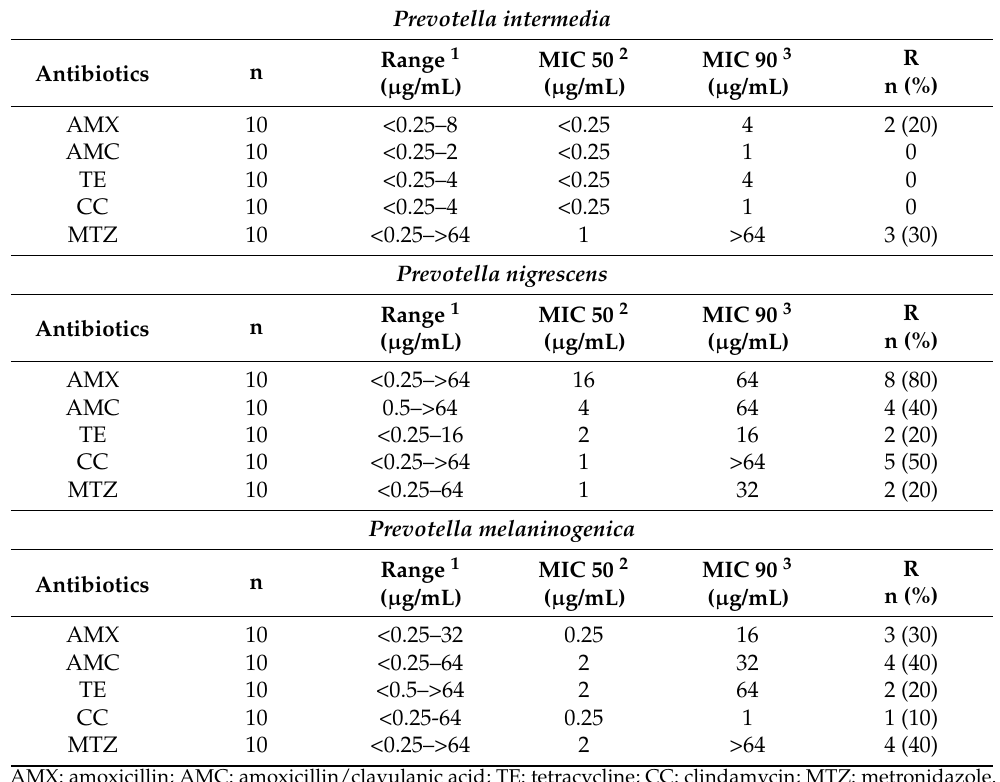
Table 3. Minimum inhibitory concentration (MIC) ranges and MIC50 and MIC90 for the tested antimicrobial drugs against Prevotella nigrescens, P. intermedia , and P. melaninogenica in oral